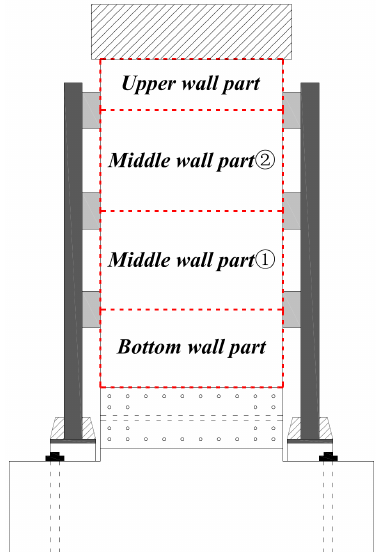
Figure 15. Cracking observation after test (blue and red lines represent the cracks as subjecting to different loading direction). ( a ) Global damage in W0; ( b ) Global damage in W1-R; ( c ) Global damage in W2-R; ( d ) Local damage in W1-R (detail from zone β , Figure 14d); ( e ) Local damage at the top of W2-R (detail from zone γ , Figure 14f); ( f ) Local damage at the bottom of W2-R (detail from zone ζ , Figure 14f).